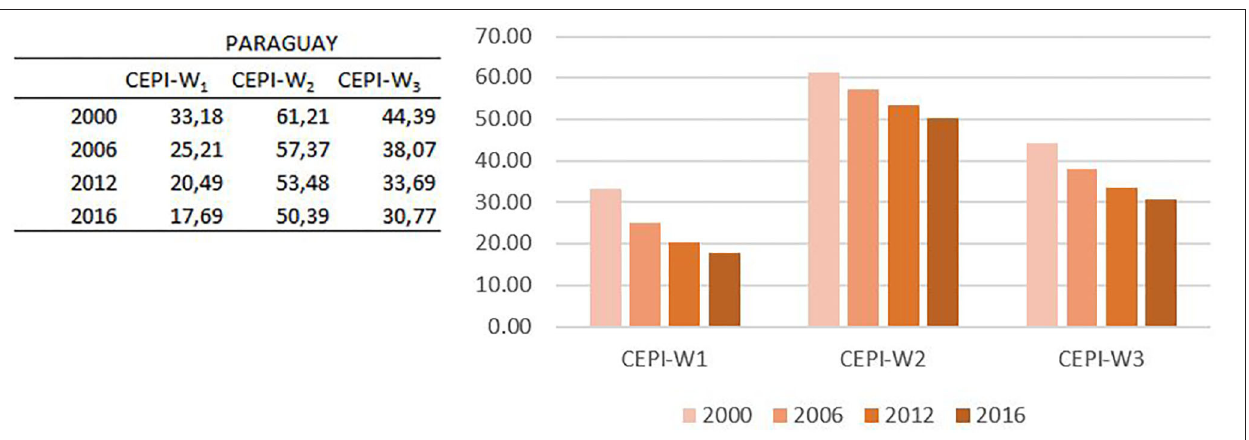
FIGURE 10 | CEPI — Paraguay (2000, 2006, 2012,